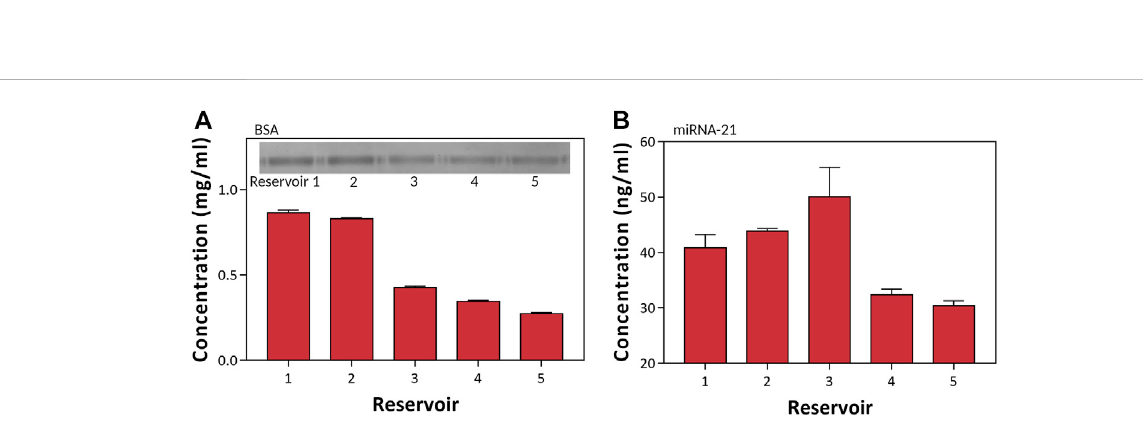
FIGURE 6 Preconcentration of BSA and miRNA-21. (A) Measurements of the BSA concentration of each reservoir using Nanodrop 280 nm wavelength and SDS-PAGE. (B) Measurements of the miRNA-21 concentration of each reservoir using Nanodrop 260 nm wavelength.